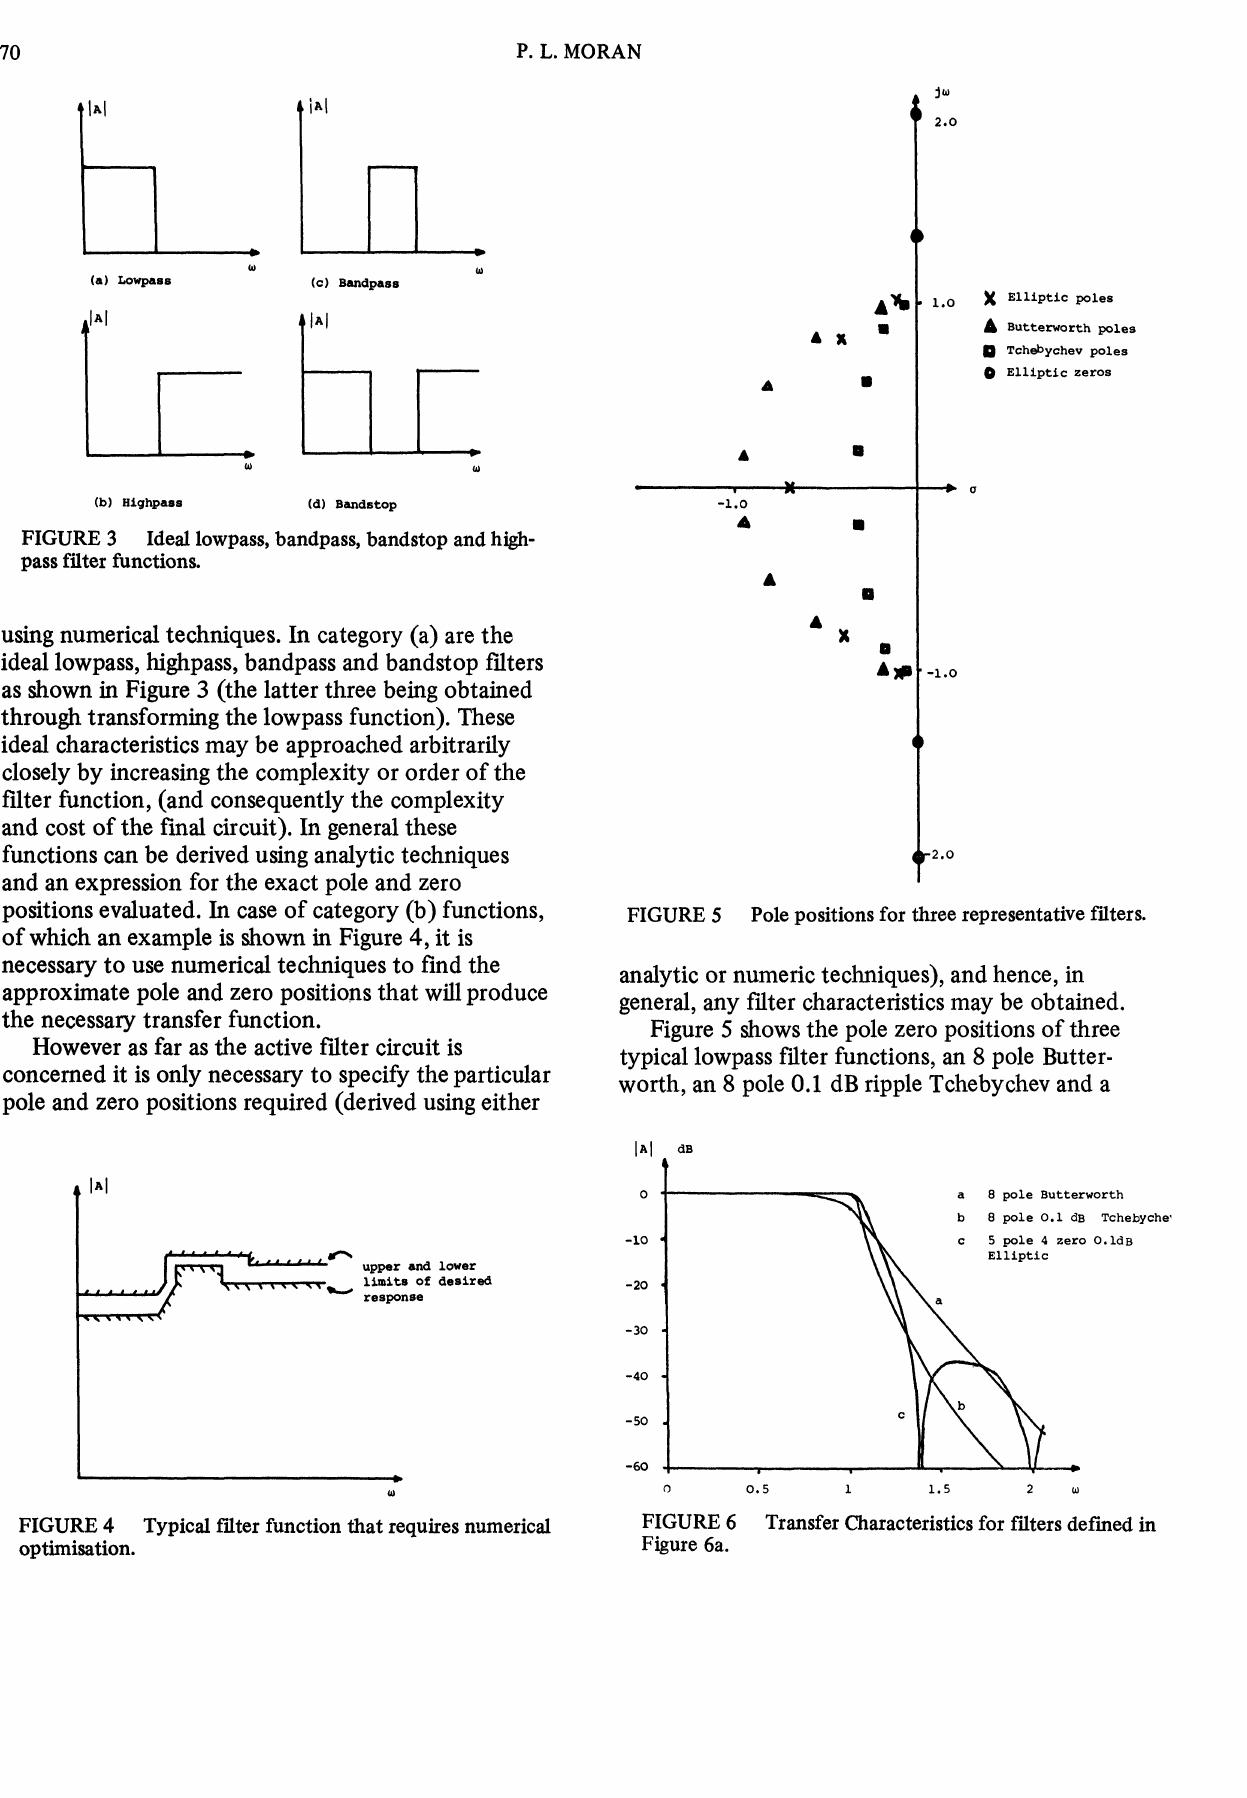
FIGURE 4 Typical filter function that requires numerical FIGURE 6 optimisation.